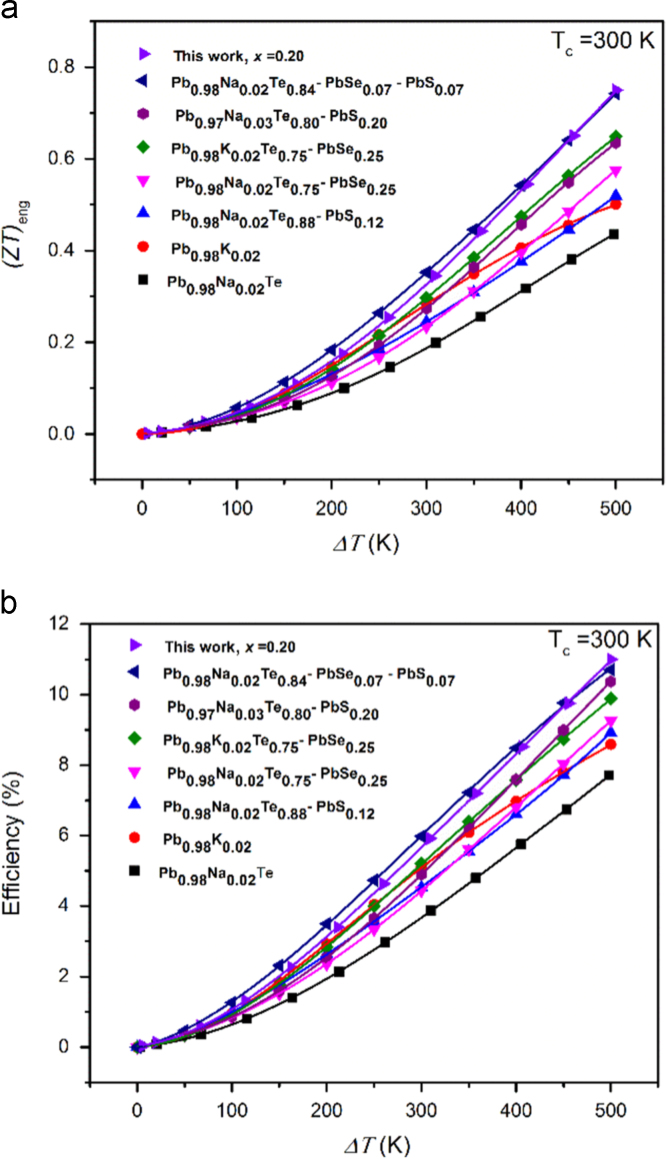
Comparative values of engineering (ZT)eng (a) and efficiency η (b) in terms of temperature difference ΔT at Tc=300 K for various compounds as indicated comparing with Pb0.98Na0.02Te, Pb0.98K0.02Te [5], (Pb0.98Na0.02Te0.88)(PbS)0.12[2], (Pb0.98Na0.02Te0.75)(PbSe)0.25[3], (Pb0.98Ka0.02Te0.75)(PbSe)0.25[5], (Pb0.98Na0.02Te0.75)(PbSe)0.07(PbS)0.07[4], (Pb0.97Na0.03Te0.80)(PbS)0.20[6].